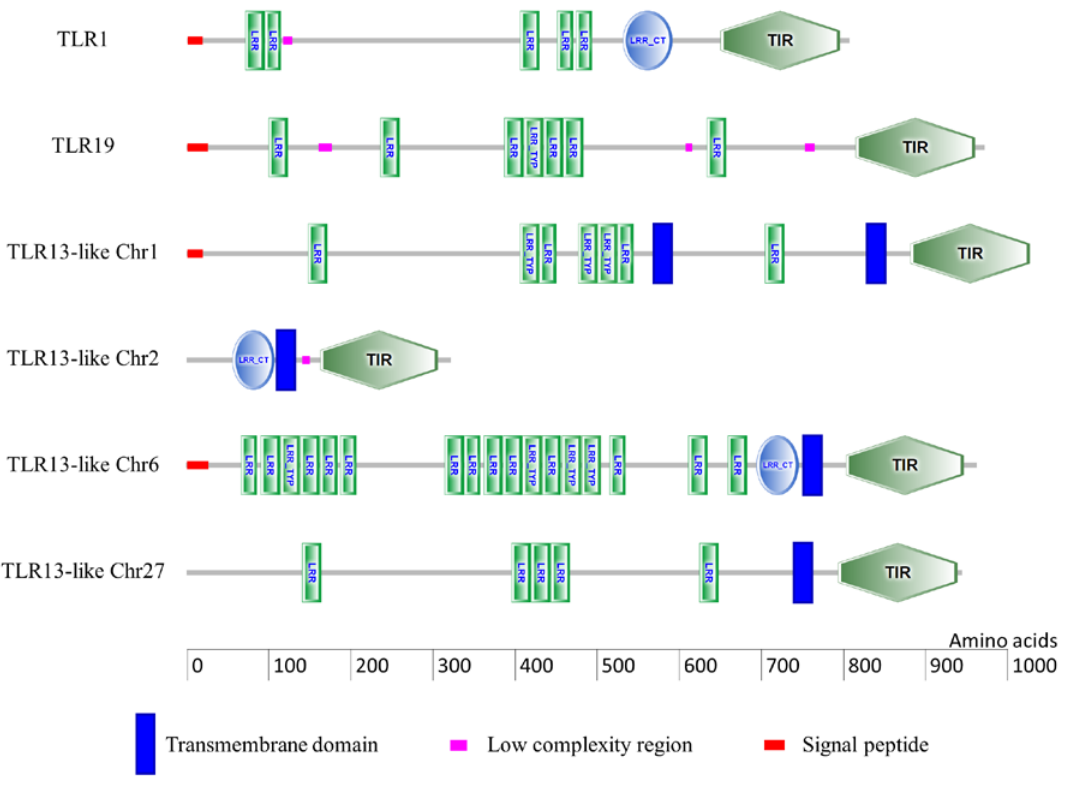
Figure 3. Schematic representation of the domain architecture of six TLRs of brown trout used in the present study. The domain architectures were predicted by the SMART tool. The domain abbreviations are as follows: LRR—Leucine-rich repeat; LRR-CT—LRR C-terminal; LRR TYP—typical LRR; TIR—Toll/IL-1 receptor.